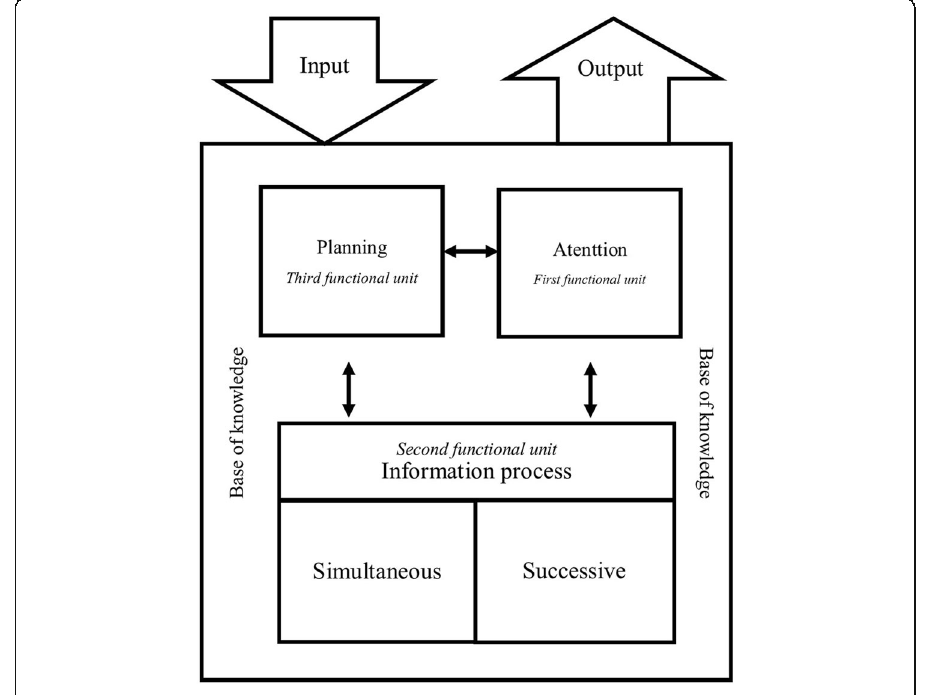
Fig. 1 PASS theory of intelligence, adapted from Das (2018,